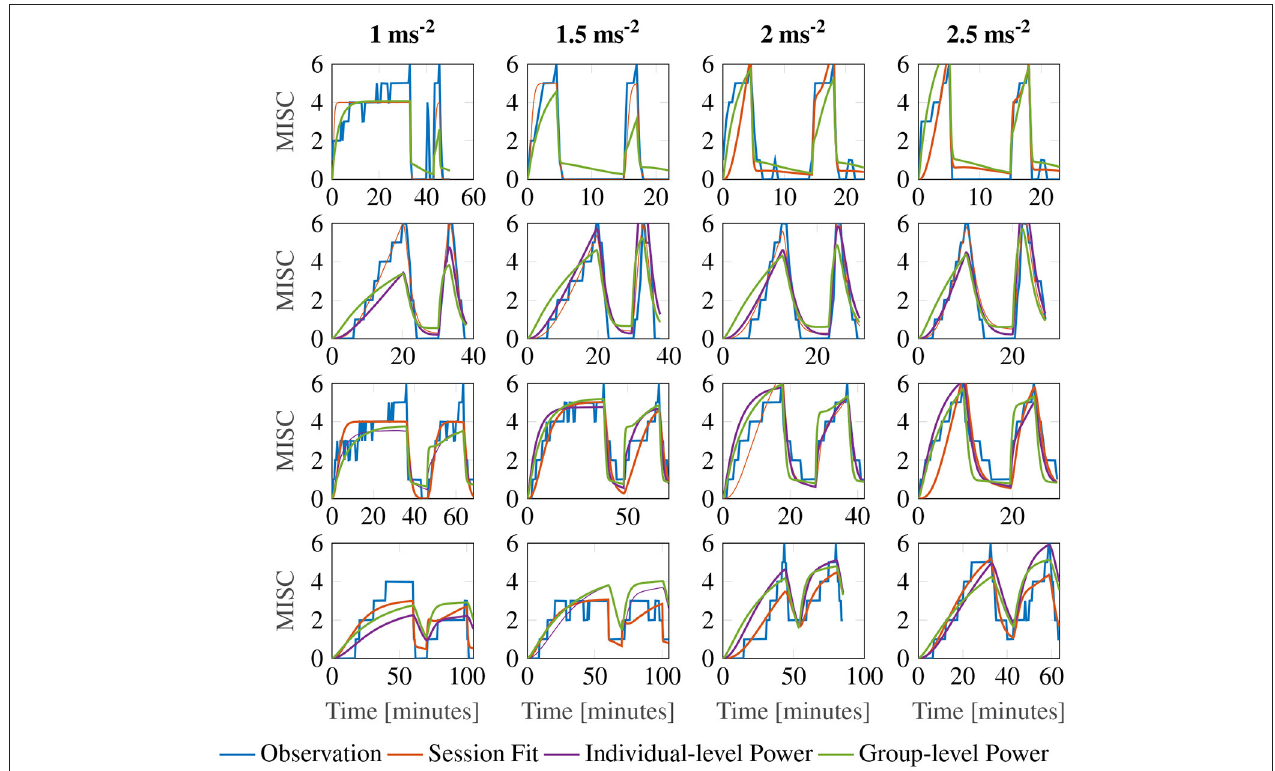
FIGURE 7 | Representative sample of fittings for the three model variations for participants 11, 12, 13, and 14. The columns show responses for each amplitude condition, increasing in magnitude from left to right. The rows show results for each participant.